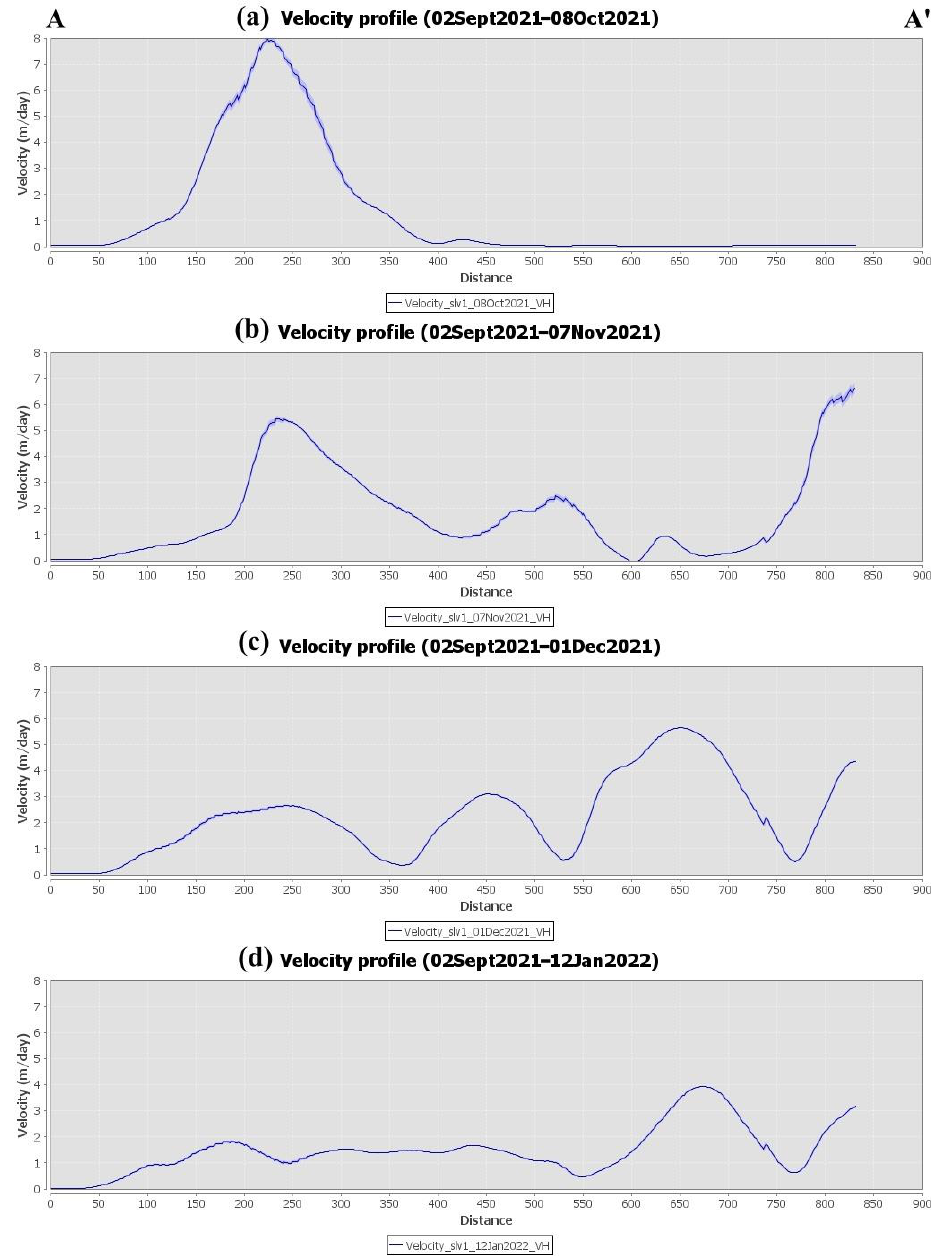
Figure 12. Lava flow velocity profiles of section AA’ throughout the different eruptive phases, obtained by processing the Sentinel-1 ascending data through offset tracking.